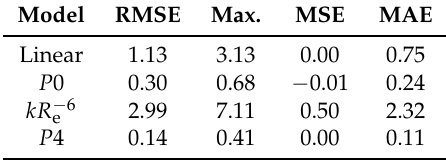
Figure 1. The predicted versus true interaction energies for the linear ( left , Equation (2)) and P 0 ( right , Equation (3)) models. In the former, a non-linear trend is seen, suggesting non-normality of errors. The gradient and adjusted R 2 value of the line in the right-hand figure are 1.0 and 0.995, respectively. A perfect model would have unit gradient and zero intercept. Table 1. Summary statistics for the linear, P 0, kR − 6 , and P 4 models over the fitting set of 60 complexes. e, ij These include the root-mean-square, maximum, mean-signed, and mean-absolute errors in kcal mol − 1 . Model RMSE Max.